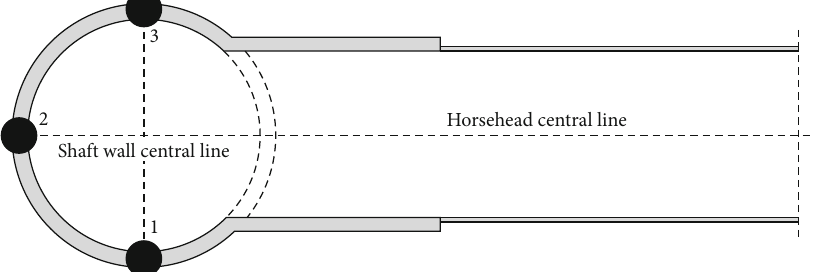
Figure 1: Distribution of measuring points.